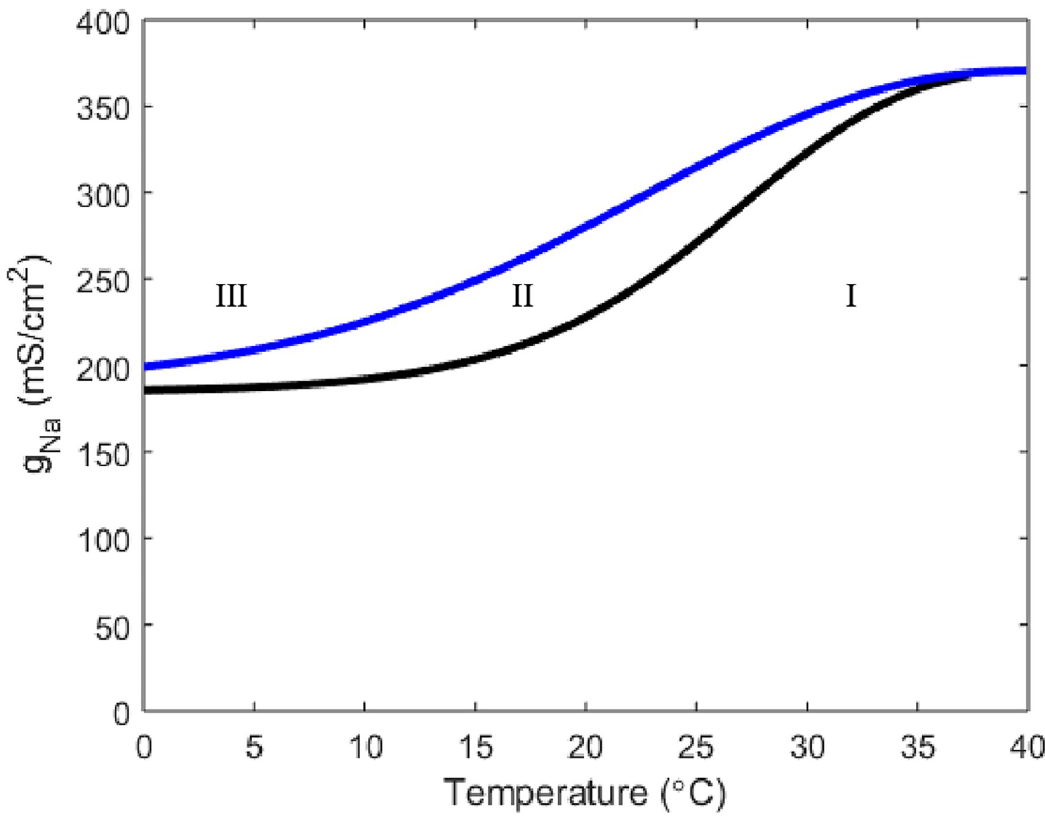
Fig 3. A two parameter bifurcation detailing the relationship between sodium maximal conductance, g curve color and regions drawn are the same in meaning to those from Fig 1. Here g